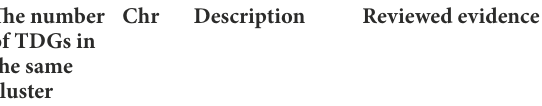
TABLE 1 TDGs with more than six genes in the same cluster and their